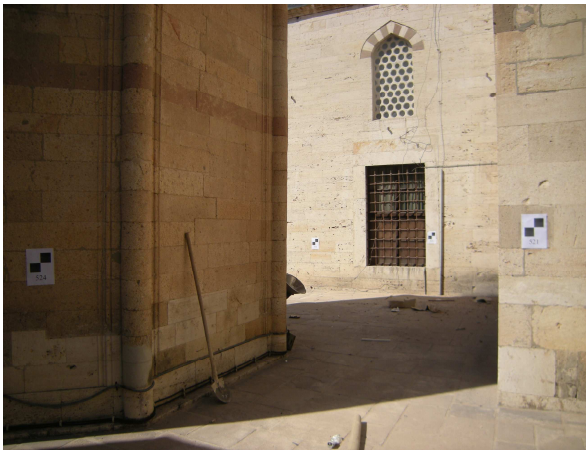
Figure 7. Control points